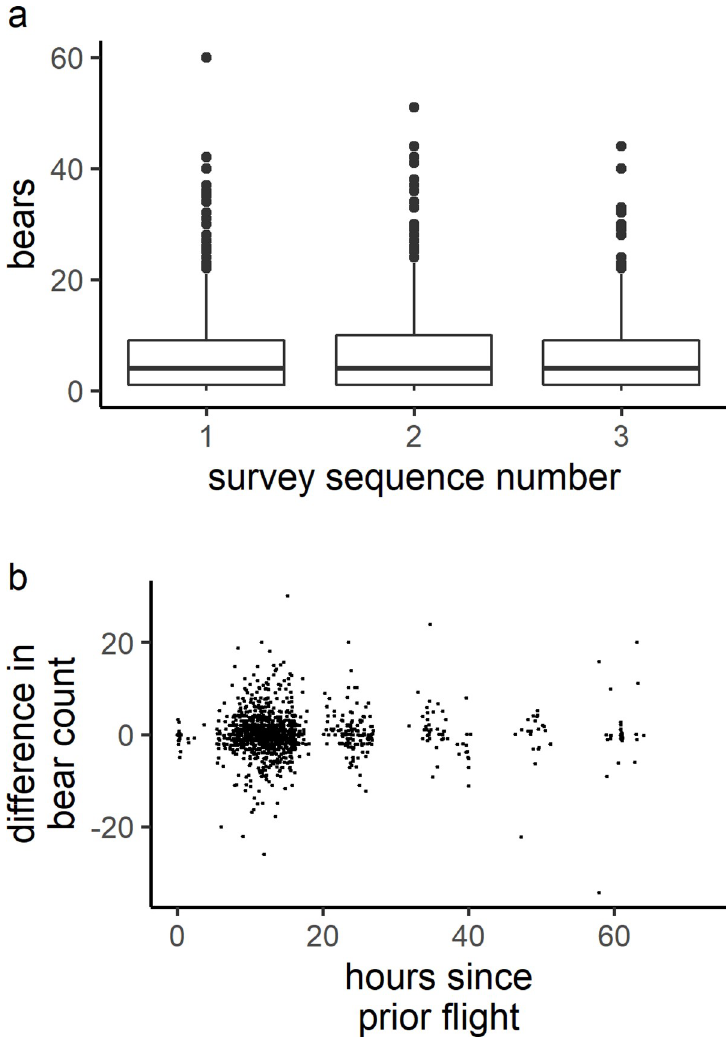
Fig 2. Comparison of bear counts from sequential aerial surveys occurring within 24 hours. a) count sequences ( n = 106) showing the total bear count from aerial surveys. There was a modest average increase of 0.029 independent bears (2% increase) in each additional survey in a survey sequence (p = 0.03). b) plot showing the relationship between bear counts and time since the previous survey ( n = 106). The effect of time since previous surveys on the number of observed bears was not significant at α = 0.05 (p =